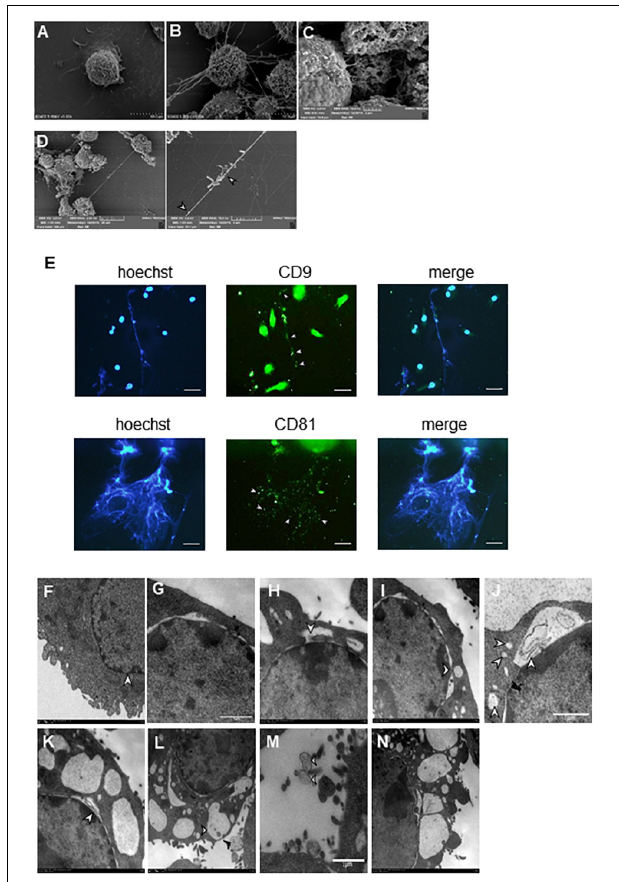
FIGURE 3 | Identification of MiET structures originated from vesicles. BV2 cells were seeded onto poly-lysine-coated glass slides for scanning electron microscopy. Cells without treatment were used as the control (A) . Other cells were treated with 2 µ M PMA (B) for 3 h, ionomycin (C) for 2 h or Listeria (MOI = 50:1) (D) for 3 h. Listeria ( D , arrow) was strung in a line or entrapped by the net structures, and some vesicle-like structures were around the net structures ( B–D , arrowhead). BV2 cells were infected with Listeria (MOI = 50:1) for 3 h. The results were examined using a fluorescence microscope showing MiETs (blue) and vesicles (green) (E) . Scale bars = 50 µ m. BV2 cells were infected with Listeria (MOI = 50:1) or treated with PMA (2 µ M) for 3 h. Transmission electron micrographs showing the complete cell nucleus without treatment were used as the negative control (F) . Listeria-infected cells are shown with separated inner and outer nuclear membranes (G) . The DNA strands could be seen in the gap between the nuclear membranes (H) . NPCs could also be seen (I) . A DNA-containing vesicle was seen budding off the nuclear envelope (J) . The nuclei were surrounded by vesicles containing DNA strands, and the plasma membranes were intact (K) . Vesicles were seen fusing with the outer plasma membrane ( L , arrowhead), and some were released directly into the extracellular space ( L , arrow). Vesicles ( M , arrowhead) were lysed and emptied their contents to form MiETs ( M, arrow) in response to Listeria. PMA-treated cells showed similar changes as Listeria-infected cells ( N